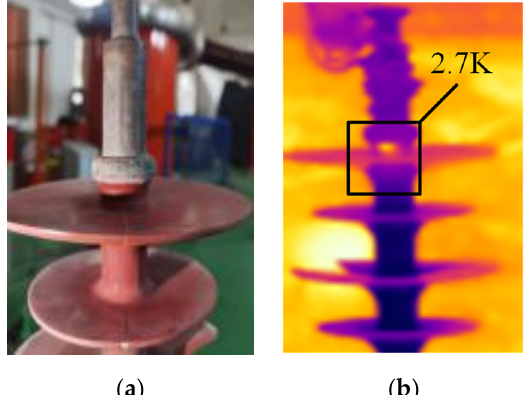
Figure 5. Temperature rise in sample #1 after removing surface contamination: ( a ) contamination cleaning; ( b ) temperature rise image.